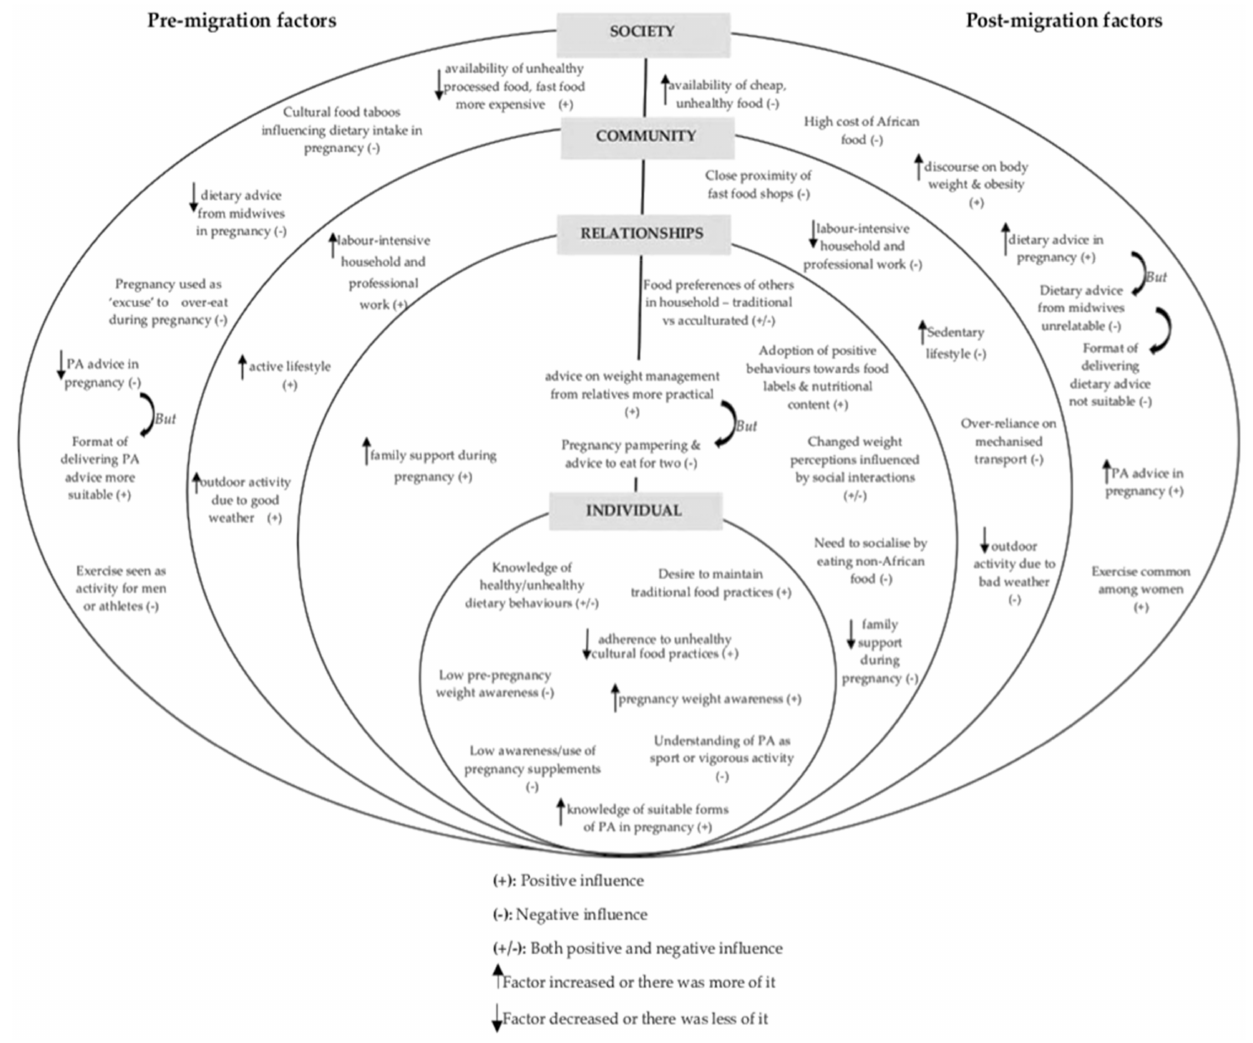
Figure 1. Conceptual framework of pre- and post-migration influences on participants weight-related behaviours (adapted socioecological